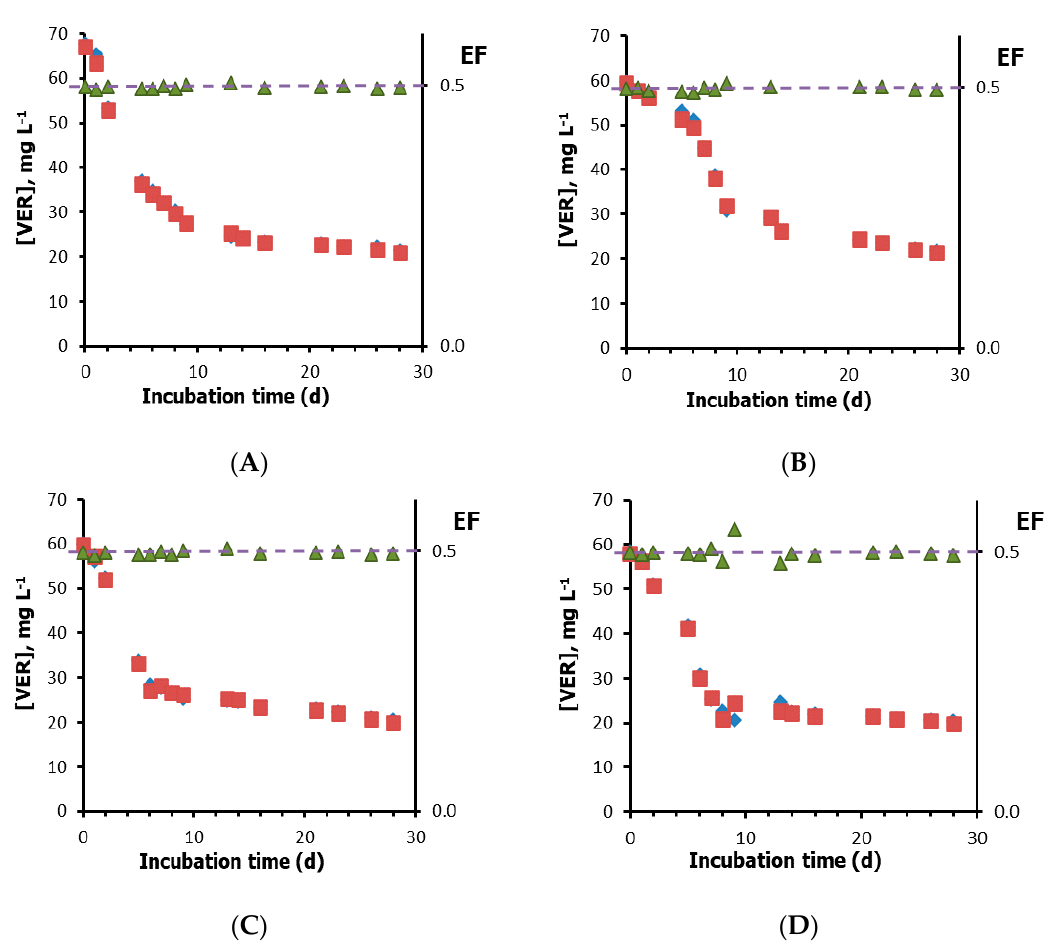
Figure 4. Estimated concentrations ( S ) and enantiomeric fraction ( EF ) obtained for verapamil (VER) in incubated samples during the biodegradability assays: ( A ), biotic assay; ( B ), abiotic assay; ( C ), biotic assay in darkness; ( D ) biotic assay supplemented with acetate. S and F values correspond to the mean of two replicates. Dashed line, EF = 0.5, represents no enantioselectivity. Symbols: ( ■ ) E1 ‐ VER; ( ◆ ) E2 ‐ VER; ( ▲ ) EF.